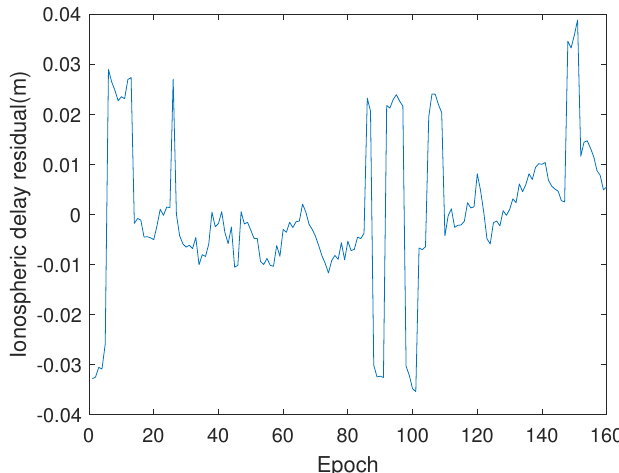
Figure 6. Total electron content delay residual of satellite 32 (baseline 2).